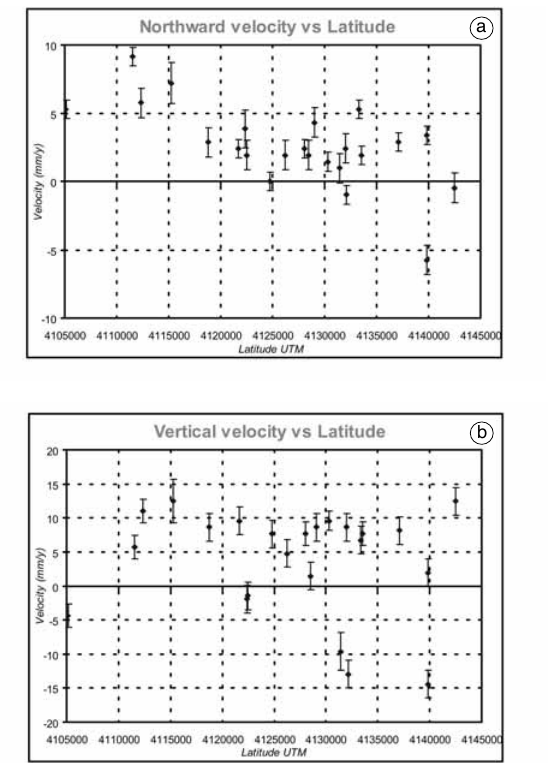
Fig. 5a,b. a) Northward component of velocities versus latitude; b) vertical component of velocities versus latitude.